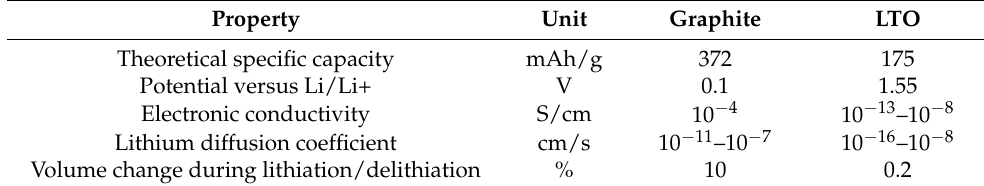
Table 1. Electrochemical and mechanical properties of graphite and LTO. Property Unit Graphite LTO Theoretical specific capacity mAh/g 372 175 Potential versus Li/Li+ V 1.55 Electronic conductivity S/cm Lithium diffusion